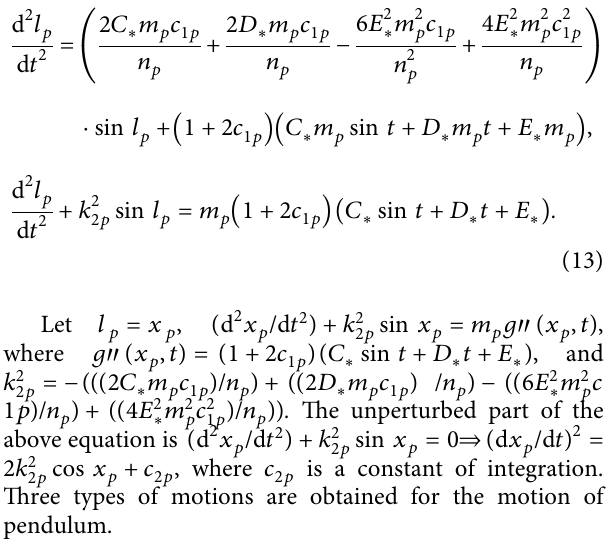
Figure 4: For n � 0 . 9 , ε � 0 . 000000000000000001 , A and e � 0 . 001. (a) Poincare map, (b) Poincare surface of section, (c) Lyapunov exponent, and (d) time